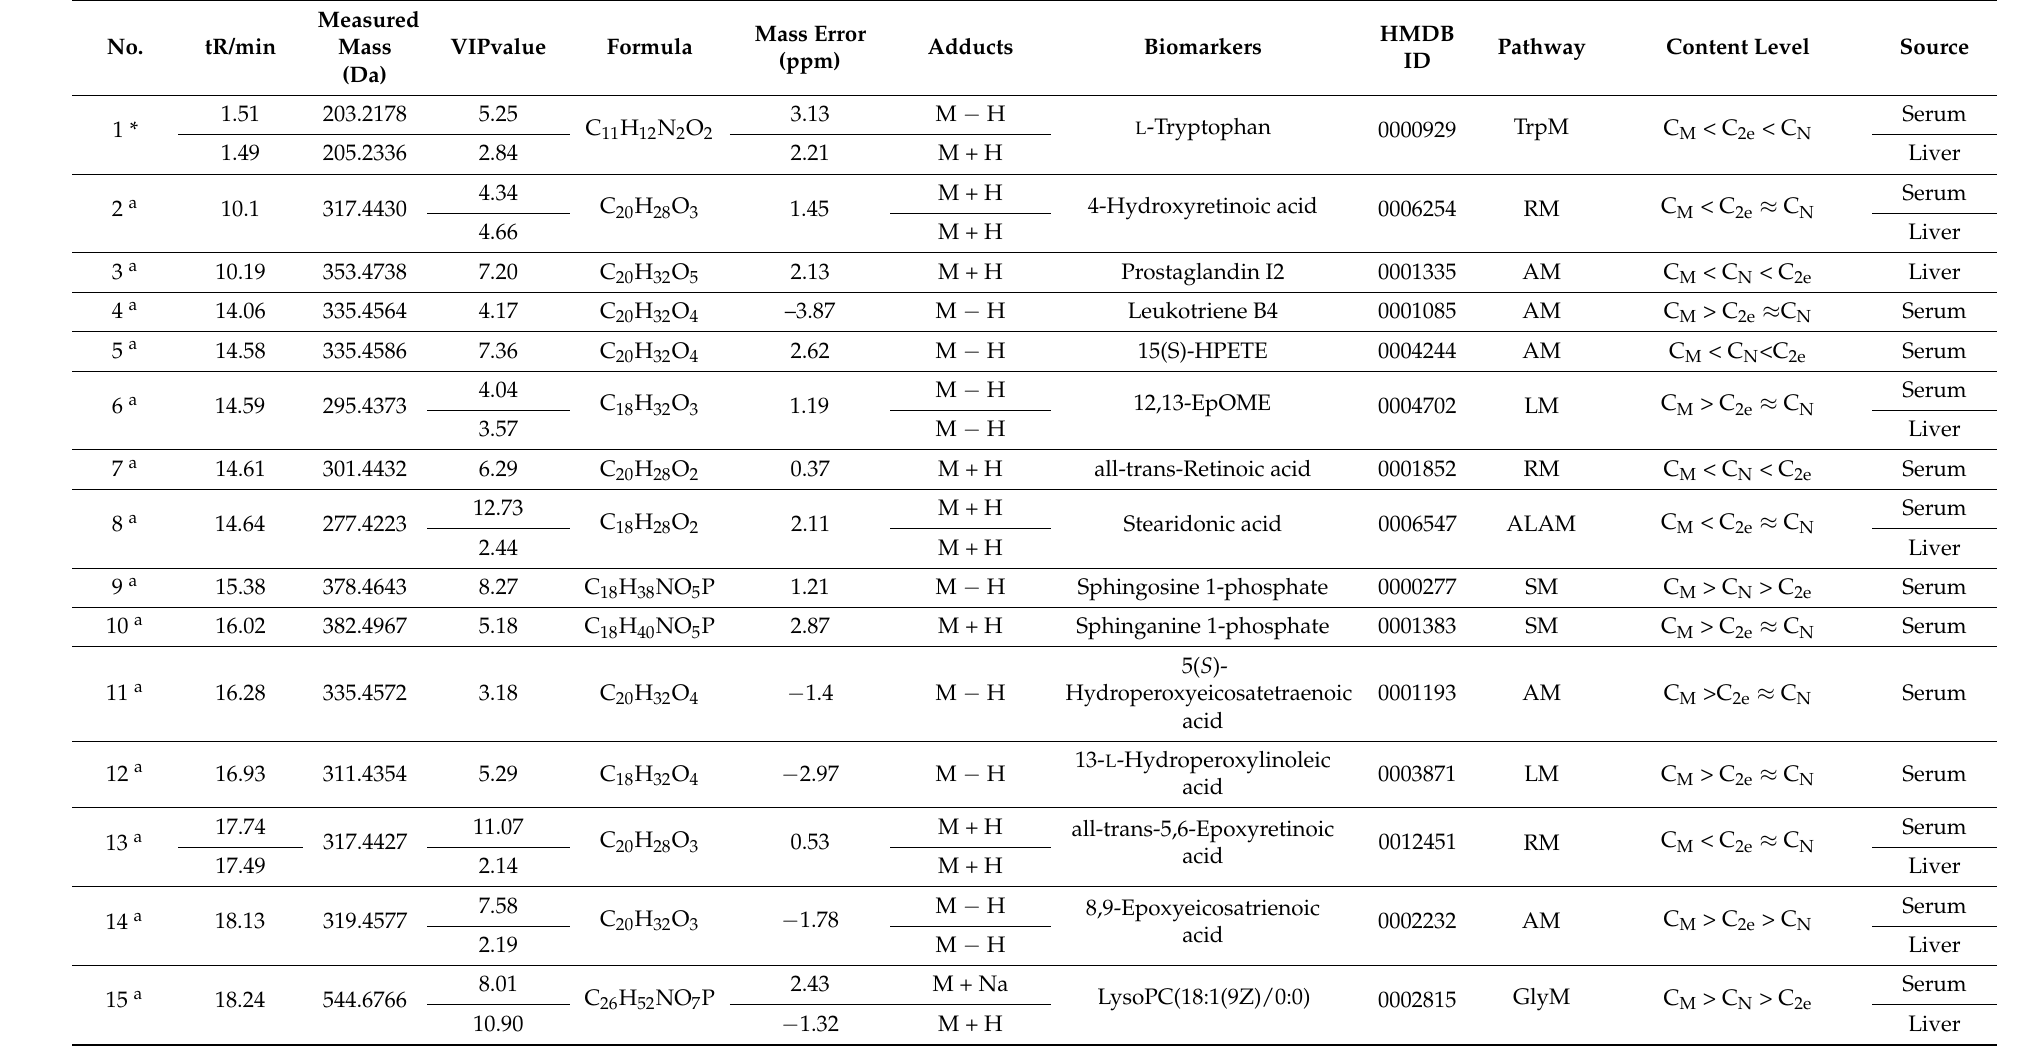
Table 6. Distinct metabolites identified in serum and liver